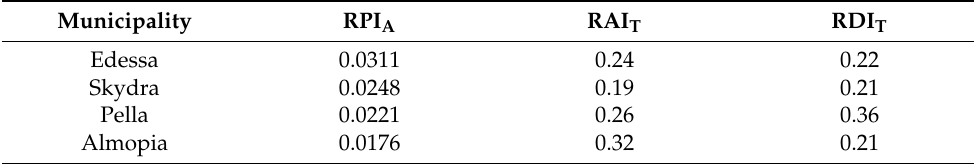
(C2) and RDI T (C3) values for the four municipalities: Table 3. Relative Priority Index (RPI A ), Total Attractiveness Index (RAI T ), and Total Dependence Index (RDI T ) values.